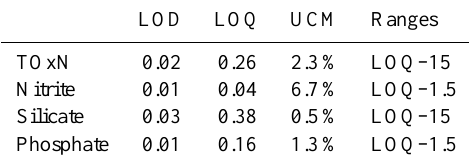
Table 4. Limit of detection (LOD), limit of quantification (LOQ), both in µ molL − 1 , and uncertainty of measurement (UCM) for the nutrient analysis. The ranges given are the linear calibration ranges, concentrations that fall above these are diluted into the linear range.